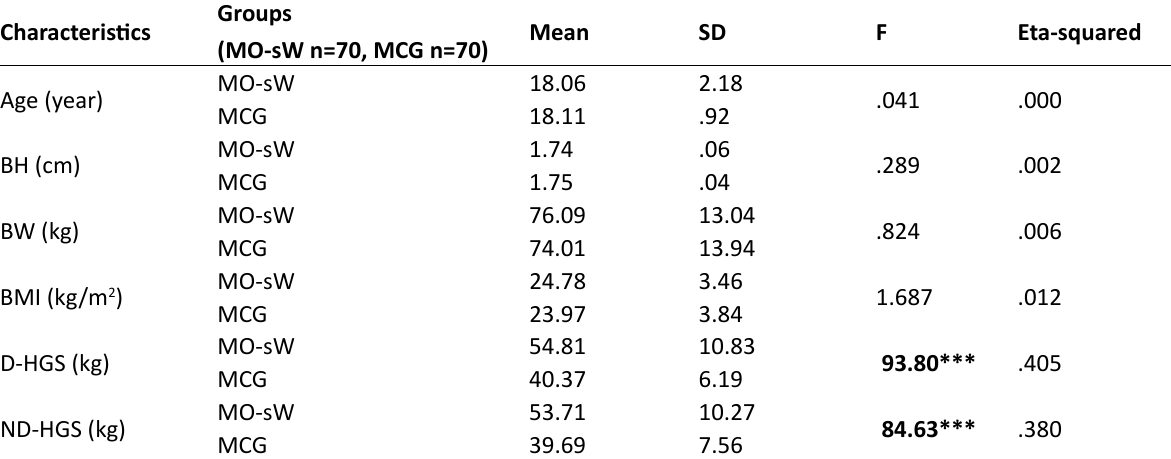
Table 1. Demographic, D-HGS and ND-HGS values of MO-sW and MCG groups.